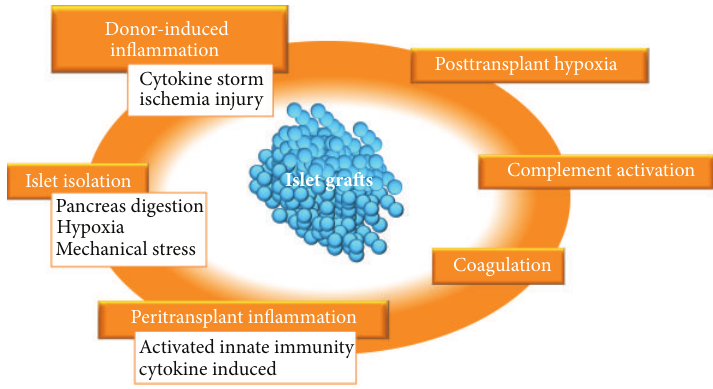
Figure 1: Factors that induce an inflammatory reaction to islet